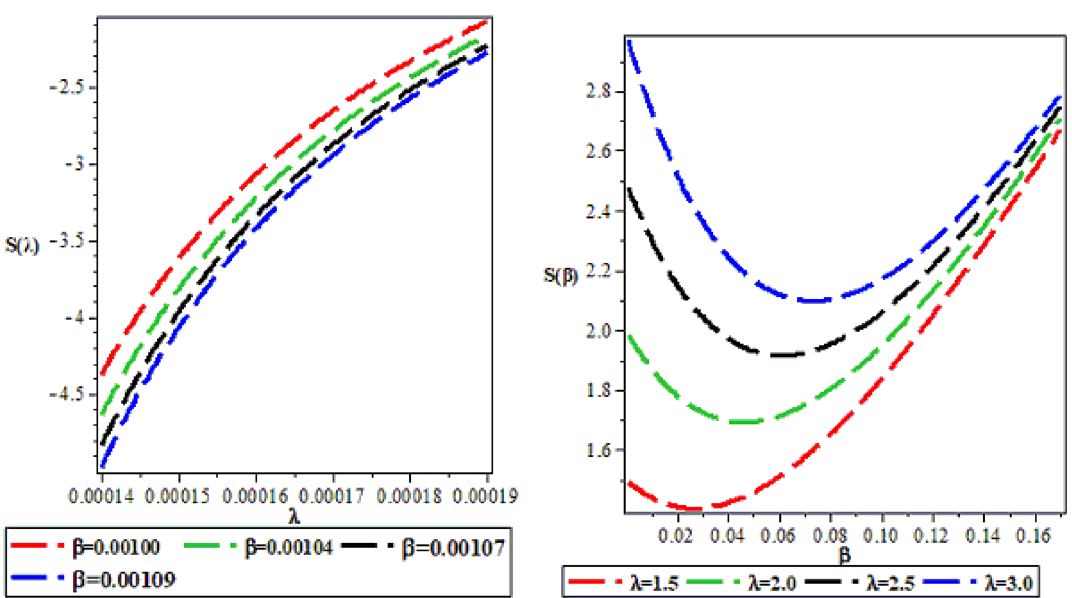
Figure 5. Variation of vibrational entropy against the maximum quantum state (λ) and the temperature parameter (β)